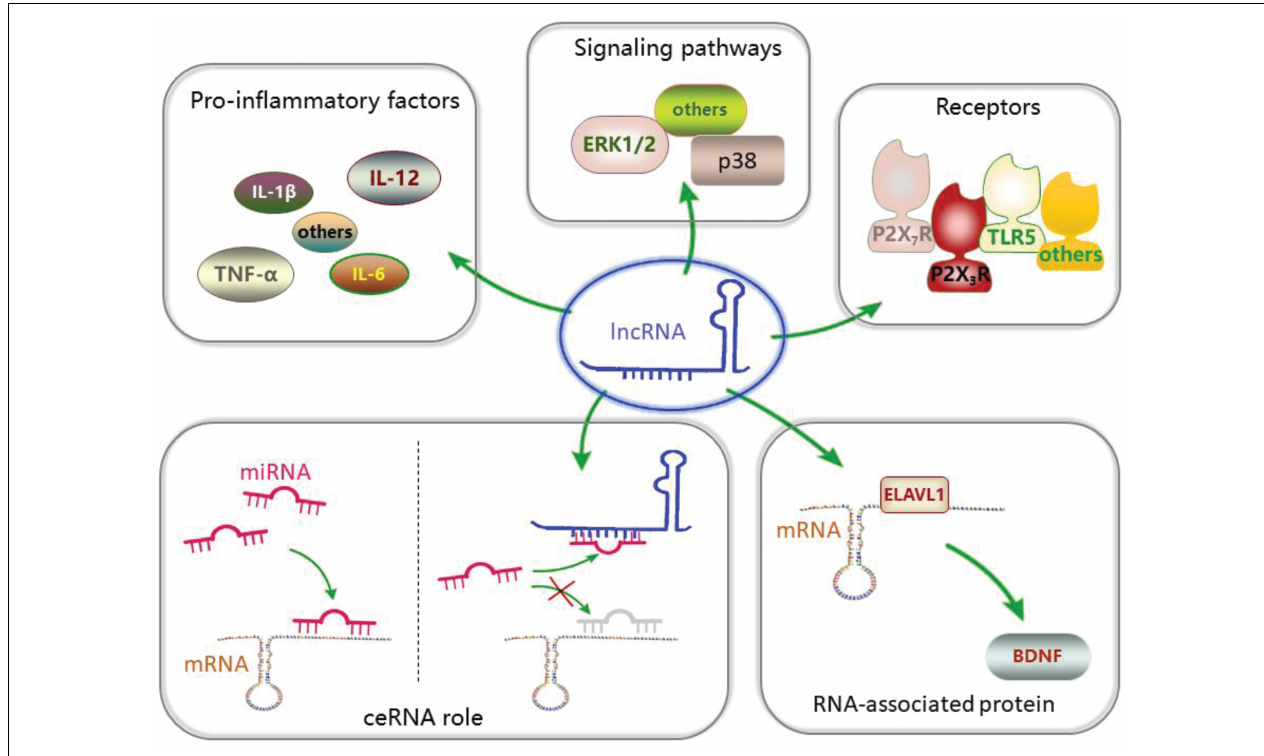
FIGURE 1 | Long non-coding RNA (lncRNAs) and their mechanism in pain transmission: lncRNAs can participate in pain transmission through various